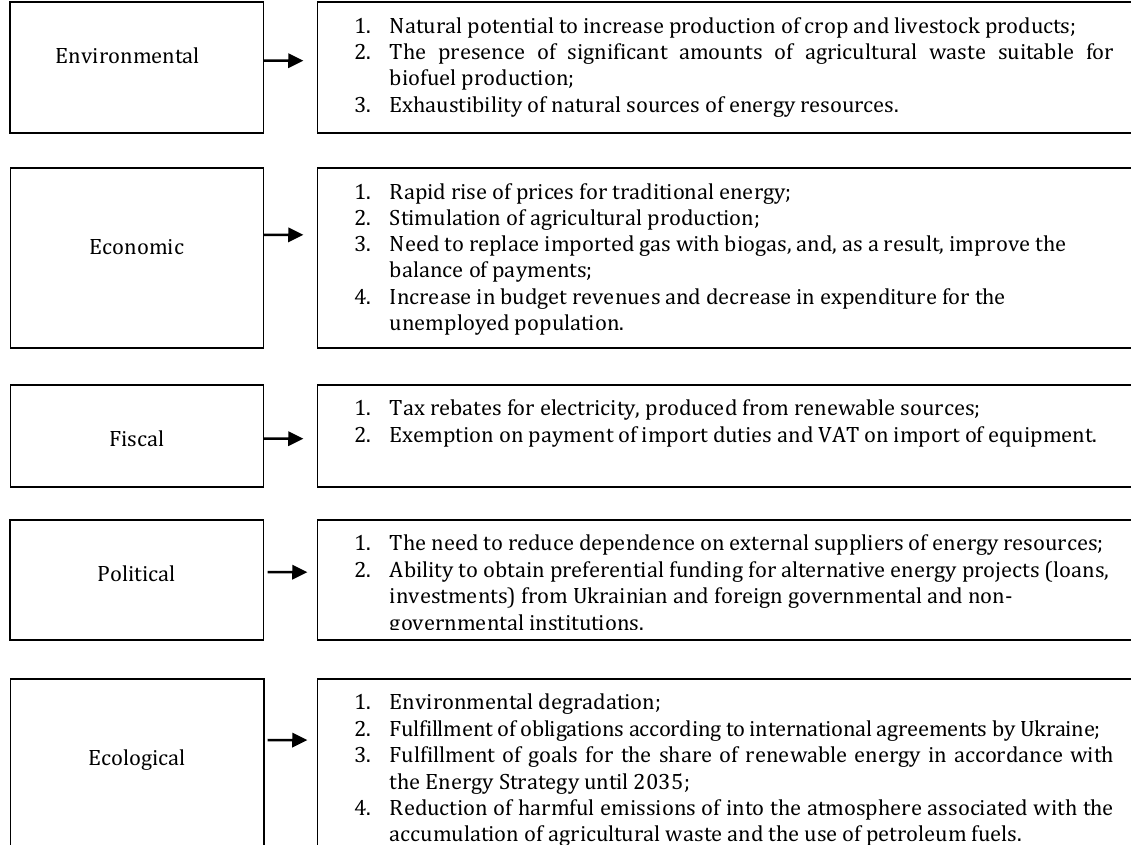
Fig. 3. Factors for the development of biofuel production from waste agricultural enterprises (Source: formed by the authors) Table 6. Potential for biogas production in Ukraine from manure (Source: calculated by the authors, January 1, 2019)